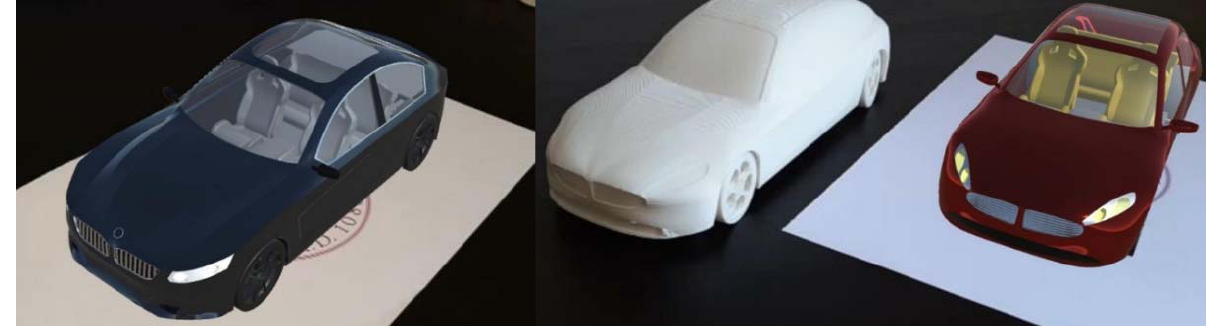
Figure 21. Augmented reality implementation of the two models.